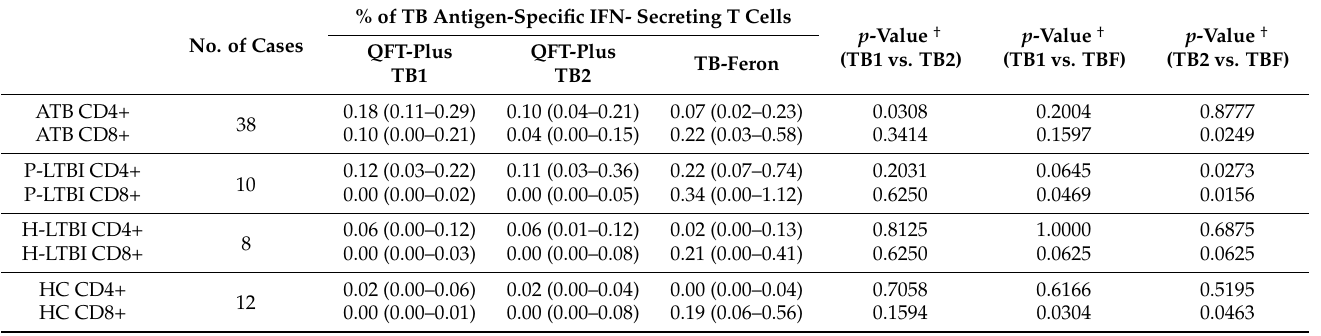
Table 4. Comparison of TB antigen-specific IFN- γ secreting T cell levels in response to TB antigens in the QFT-Plus and TB-Feron assays measured by flow cytometry intracellular cytokine